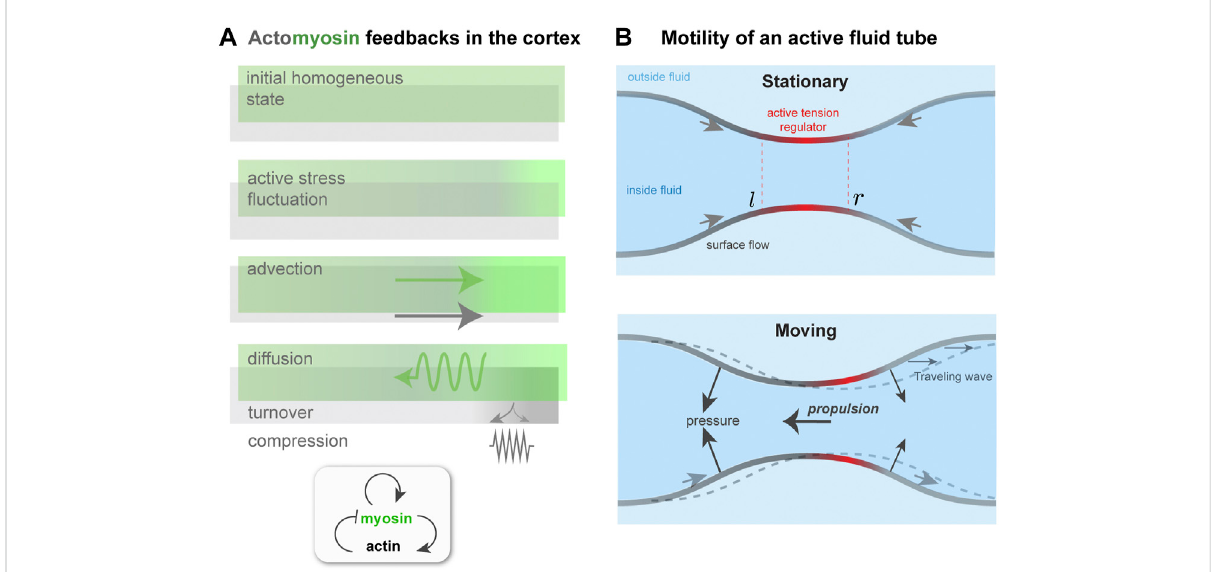
FIGURE 3 Contractility regulation in the cortex, fl ows, and symmetry breaking. (A) . Mechanochemical feedback in a simpli fi ed one dimensional actomyosin cortex. A localized increase inbound myosin concentration (green) creates higher contractile stressthan elsewhere. The resulting force advects myosin, tending to reinforce the initial increase, which is counteracted by diffusion. Co-advection of actin (gray) has an inhibitory effect, because of opposing compressive stress and turnover, which penalizes density changes away from the initial, homeostatic state. In the inhomogeneous patterned state, steady-state state fl ows, in the presence of a momentum absorbing substrate, can give rise to migration. (B) Proposedmigrationmechanismbasedontheoryofself-organizedactivetubepatterningMietkeetal.(2019b).Acontractility-basedinstabilityonthe tube surface leads to an inhomogeneous active stress regulator pro fi le, as in panel (A) . This concentrates the active stress and pinches the tube. A situationwheretheregulatorpeakiscenteredonthepinch(Stationary)maybeunstable(seetext),givingrisetoabrokensymmetrystate.Thisstateis characterized by peristaltic surface waves; in the presence of an outer fl uid, directed motion would